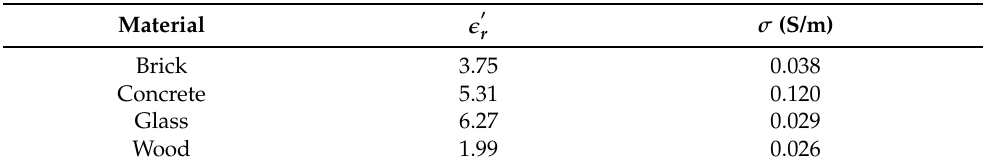
Figure 3. Comparison of the reflection coefficients of brick, concrete, glass, and wood. Table 2. Electrical properties of wall materials [4].